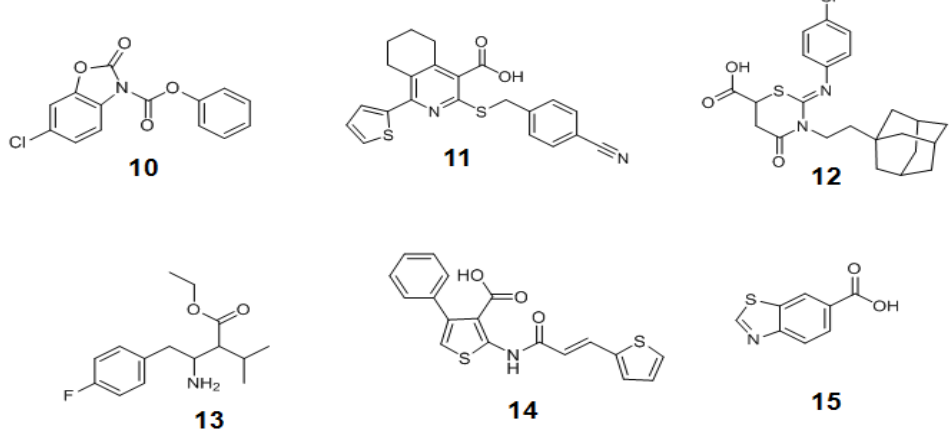
Figure 13. Structures of in vitro OGT